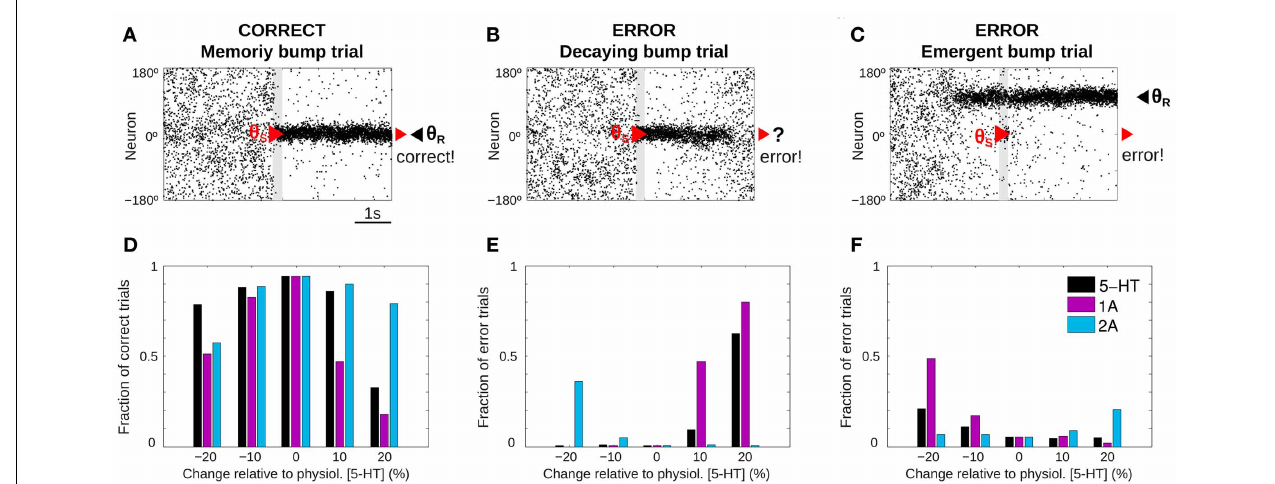
FIGURE 2 | 5-HT modulates SWM performance in the network model. (A–C) Example of rastergrams of simulations with 3s fixation, a cue presentation of 250ms (gray bar) and a delay period of 3s. Panel (A) shows a correct trial: at the end of the delay period the memory bump is in the same position where the cue was presented. Possible errors can be due to: memory disappearance before the end of the delay period ( B , decaying bump trial) or emergence of a spurious, misaligned bump ( C , emergent bump trial).